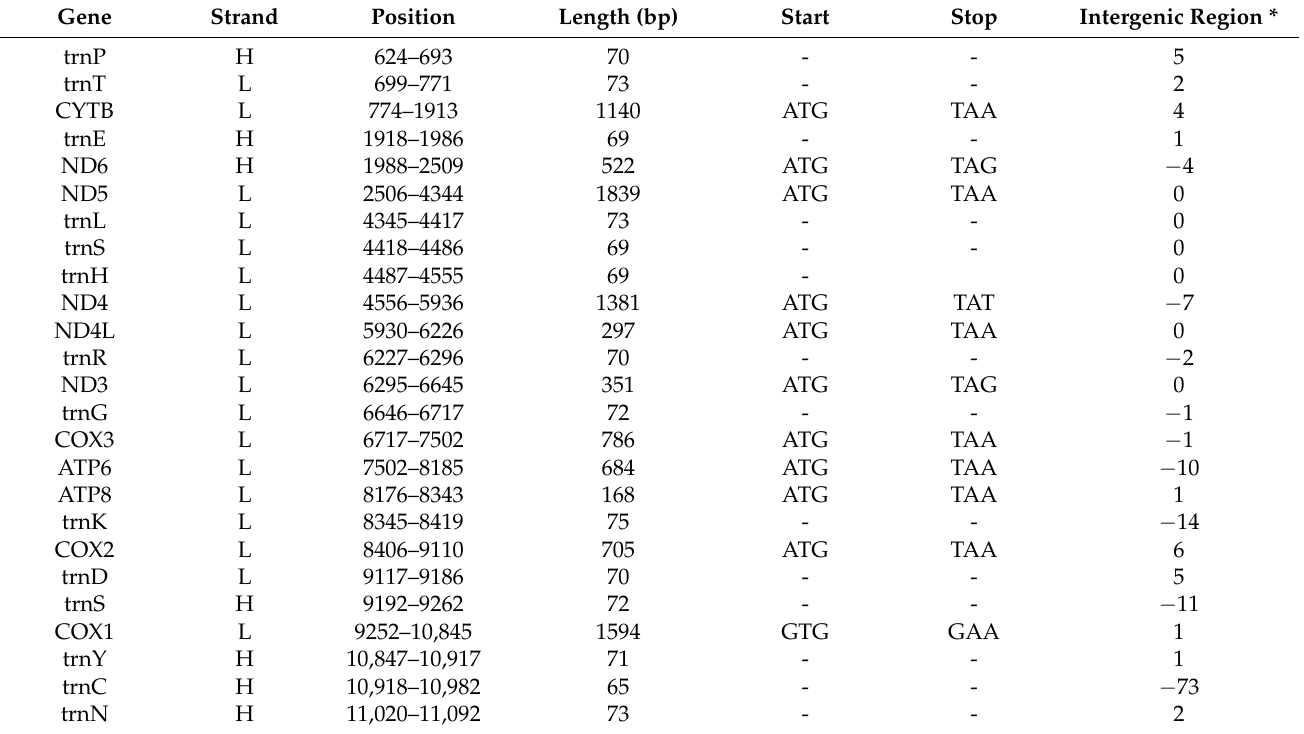
Table 1. Organization of the mitochondrial genome of S. brevidorsalis